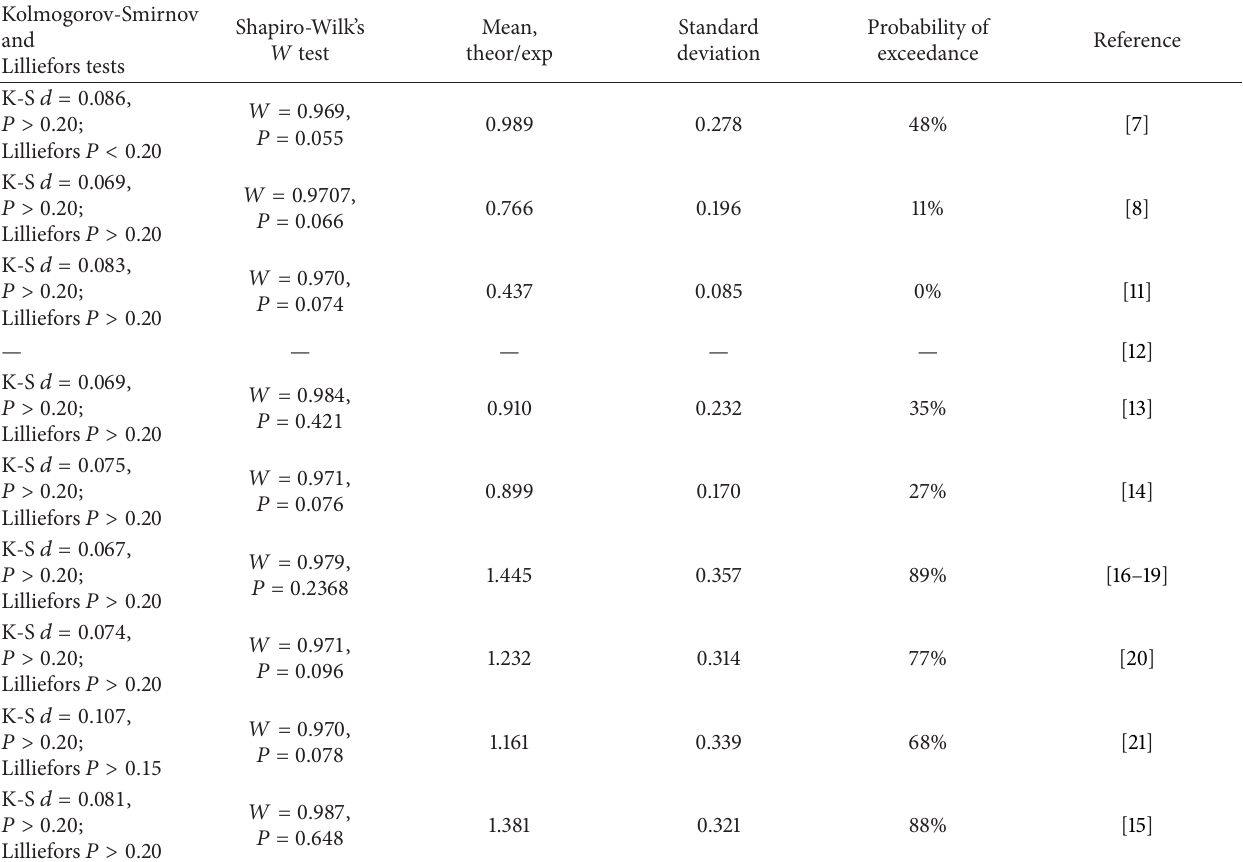
Table 3: Results of statistical modeling of 𝑥 2 .